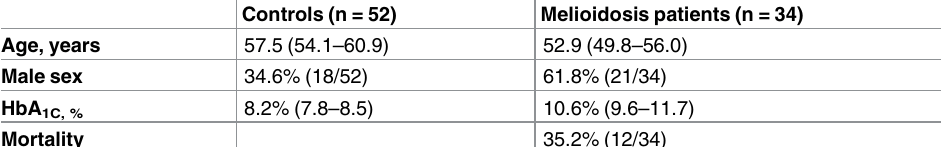
Table 1. Baseline characteristics from 52 controls and 34 melioidosis patients. Age, glucose and HbA 1 c are reportedas mean (95% confidenceinterval). Male sex and mortality are reportedas percentages (no).